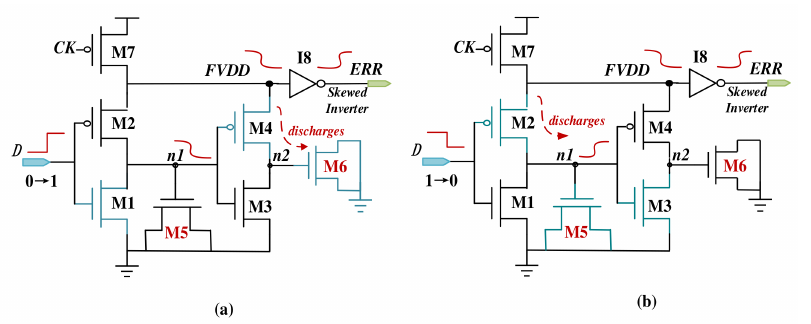
Figure 3. The schematic and operation of the proposed NTSD: ( a ) the input data D transitions from